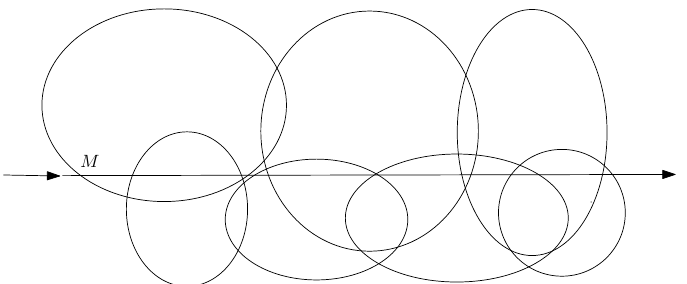
Figure 6. A drone M is traversing a straight lime trajectory. Its exposure during the trajectory is measured by the sum of the exposures from each of the regions (depicted as ovals) within its